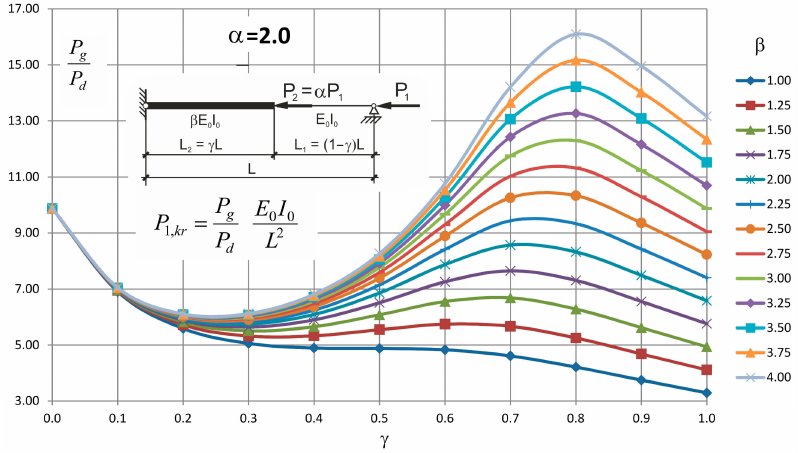
Figure 8. Values P g /P d for α = 2.0 and for different values of β and γ